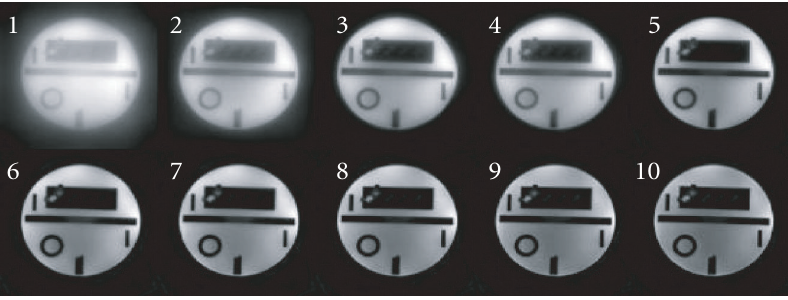
Figure 6: Reconstructed images from spiral sampling of real phantom data for image size 256 × 256 showing output from iterations 1 through 10. We start to see diagnostic quality images after only a few iterations.